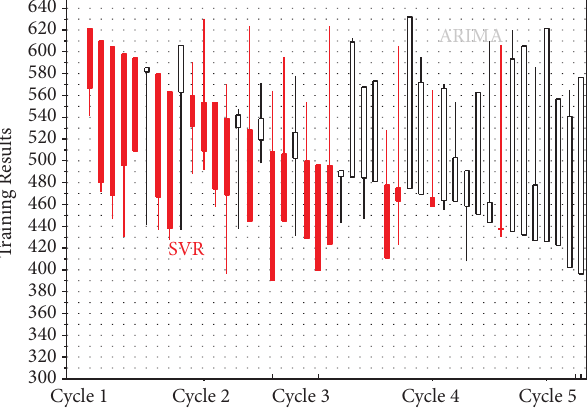
Figure 5: Simulation of training results of SVR-ARIMA